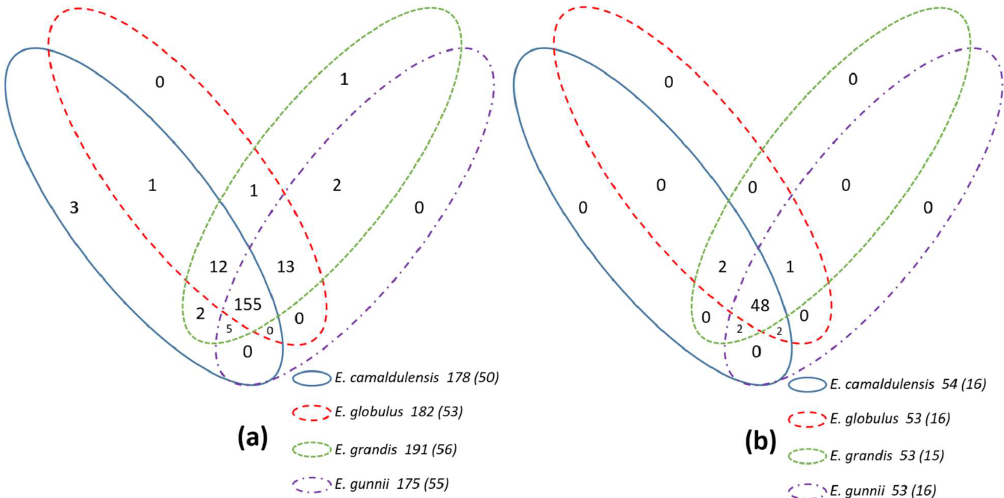
Figure 3. Venn diagrams of the ROS genes in the four Eucalyptus species. The Venn diagrams show the numbers of peroxidases gene shared between the four Eucalyptus species: E. gunnii , E. camaldulensis , E. grandis and E. globulus . ( a ) Venn diagram of CIII Prx family; ( b ) Venn diagram of other 10 ROS gene families. The total gene numbers of each organism, represented by the ovals, were written on the left of each specific name with the numbers of pseudogenes enclosed in brackets. The area of every intersection region and the gene number are not to scale.